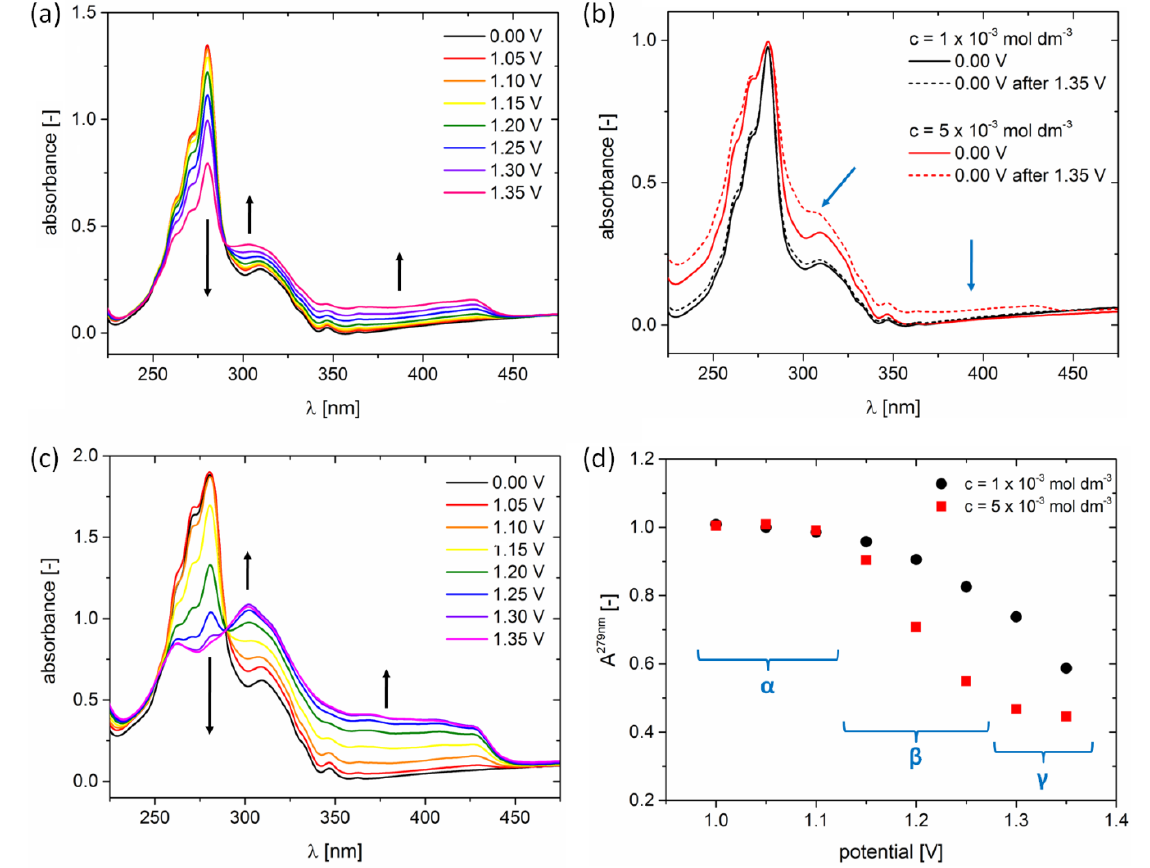
Figure 4. UV-Vis spectroelectrochemistry of ( a ) 1 × 10 − 3 mol dm − 3 and ( c ) 5 × 10 − 3 mol dm − 3 H5T solutions in dichloromethane containing 0.2 mol dm − 3 of Bu 4 NBF 4 as the supporting electrolyte. The black arrows point out the evolution of spectra. ( b ) Normalized UV-Vis spectra of H5T at 0.00 V, prior to (solid lines) and after (dashed lines) applying 1.35 V. Black and red curves represent 1 × 10 − 3 mol dm − 3 and 5 × 10 − 3 mol dm − 3 H5T concentrations, respectively. The blue arrows point out the spectral changes that appeared in the 5 × 10 − 3 mol dm − 3 solution of H5T after applying 1.35 V. ( d ) Evolution of A 279nm absorption maxima of 1 × 10 − 3 mol dm − 3 and 5 × 10 − 3 mol dm − 3 H5T concentrations, represented by black dots and red squares,